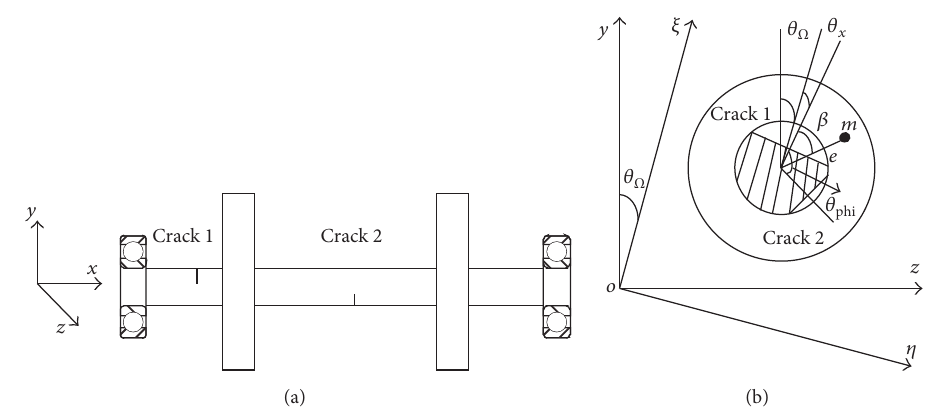
Figure 2: (a) Schematic diagram of cracked two-disc rotor-bearing system. (b) Definition of rotating and stationary coordinates.